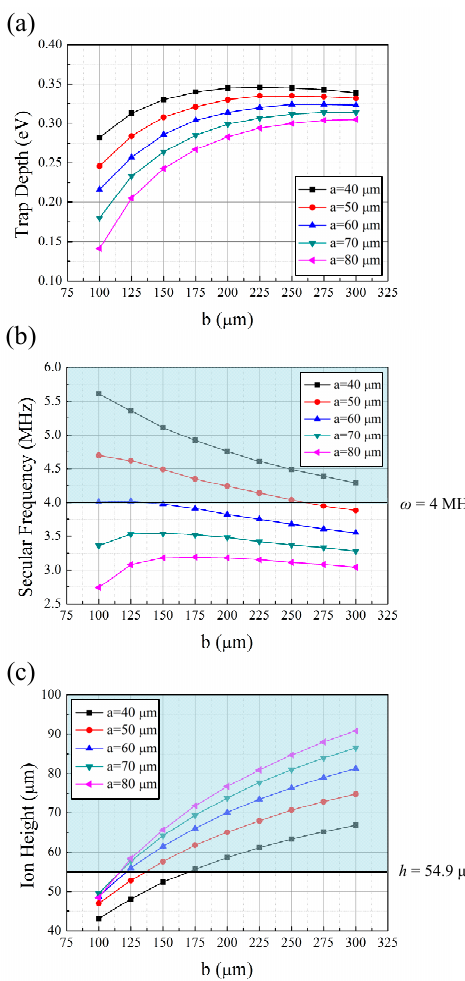
Figure 9. Simulation results for the case of trapping 171 Yb + ions, with the q -parameter fixed at 0.25, as functions of a and b . We tune the q -parameters to 0.25 in each simulation set by adjusting the RF frequency. The blue blocks represent the regions that satisfy the constraints considered. ( a ) trap depth; ( b ) radial secular frequency; ( c ) ion height.